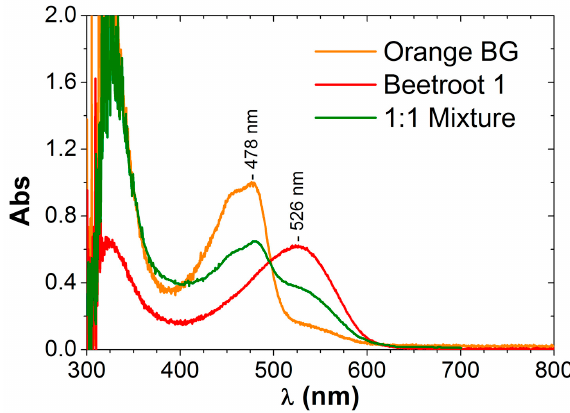
Figure 7. UV-Vis spectrum of dye mixture (green line) 1:1 orange bougainvillea extract with beetroot extract, both with Solution 1. Spectra of individual dyes are also